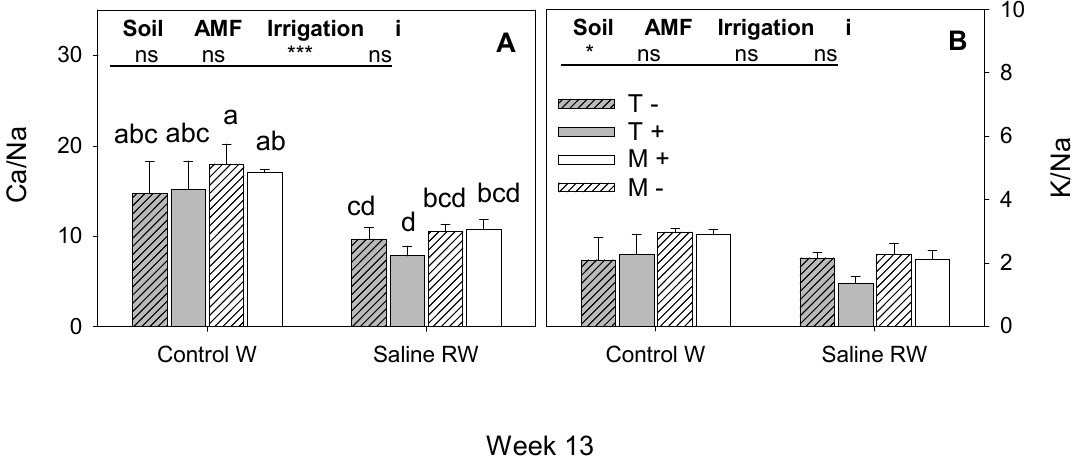
Figure 2. Leaf Ca/Na ( A ) and K/Na ( B ) ratios for irrigation with control water (Control W) and saline reclaimed wastewater (Saline RW) in traditional soil (T) or mixed substrate (M) without ( − ) and with AMF (+) inoculation. Results of one-way and three-way ANOVA tests on these parameters, for independent variables (soil, AMF and irrigation) and their interaction (i). Different lowercase letters indicate significant differences between treatments according to Duncan test at p ≤ 0.05. * p < 0.05, and *** p < 0.05. p > 0.05 non-significant differences are indicated by “ns”.